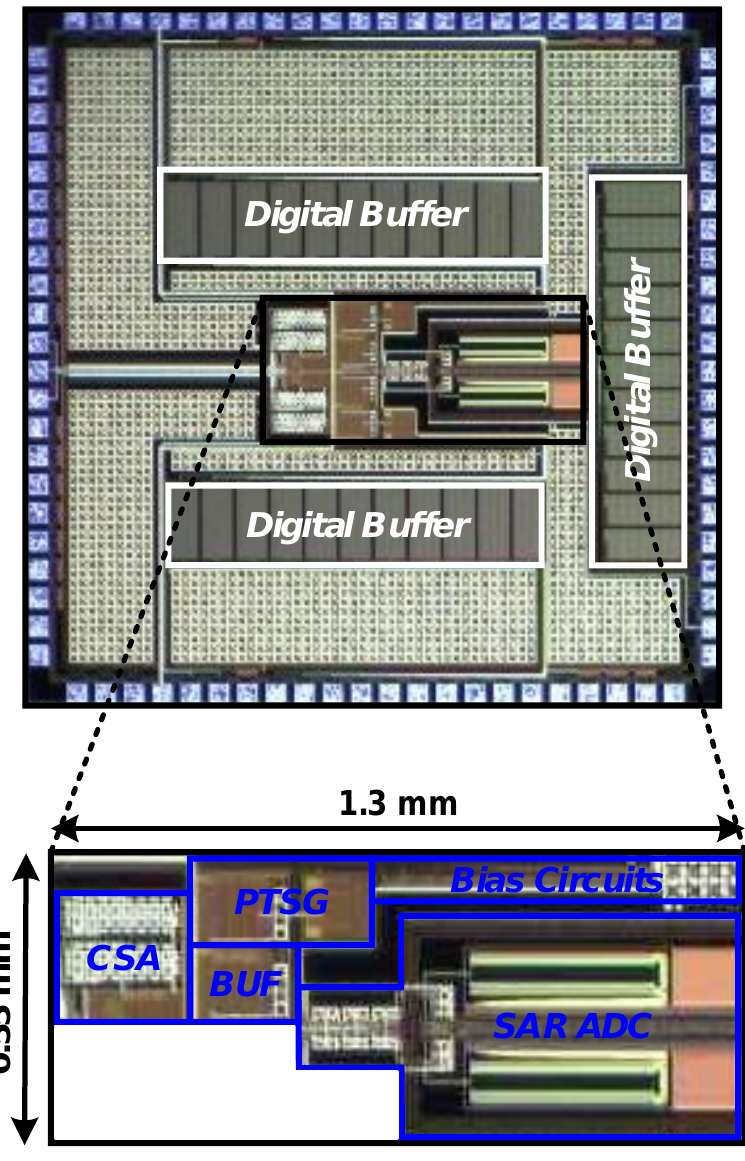
Figure 9. Die photograph of the proposed radiation sensor interface IC. Table 1. Performance summary and